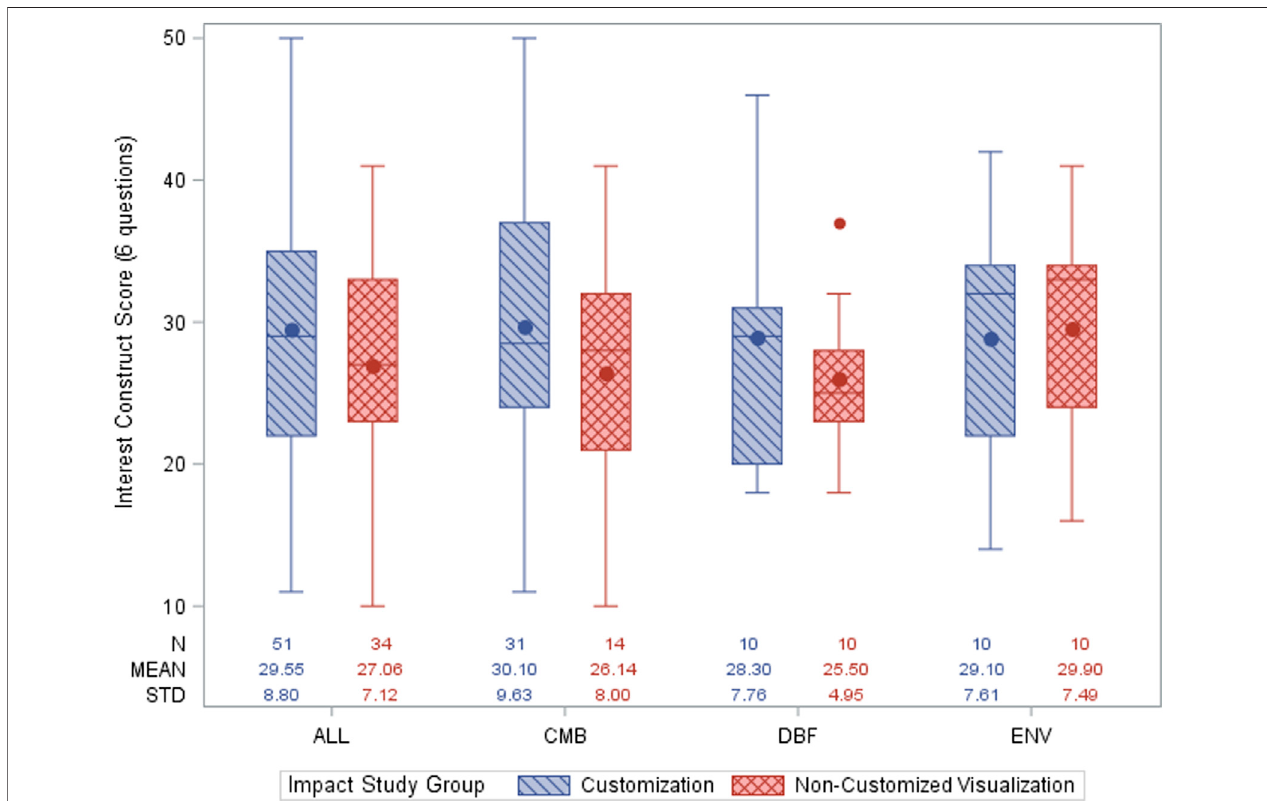
FIGURE 5 | Comparison of the interest construct for study groups: Overall (ALL) and across all three courses (CMB), (DBF), (ENV).